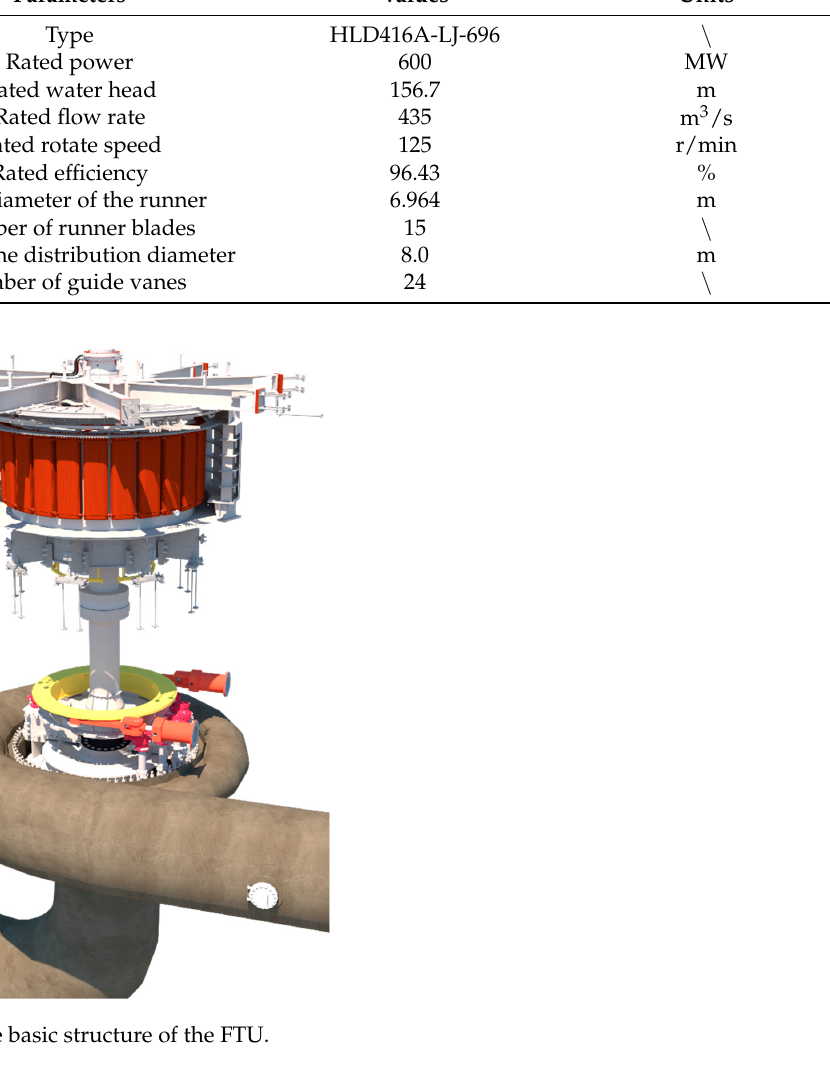
Figure 7. The position of the monitoring sensor. The operating parameters of the FTU are monitored by the supervisory control sys ‐ tem of the hydropower station. The vibration signals of critical components are acquired by a PSTA ‐ 2100 state monitoring system. They are transmitted to the computer monitor ‐ ing system of the hydropower station through the TCP/IP protocol and Modbus 485 pro ‐ tocol, respectively. The physical distance of the transmission link is usually above several thousand meters, including multiple switches, routers, and different transceiver devices.